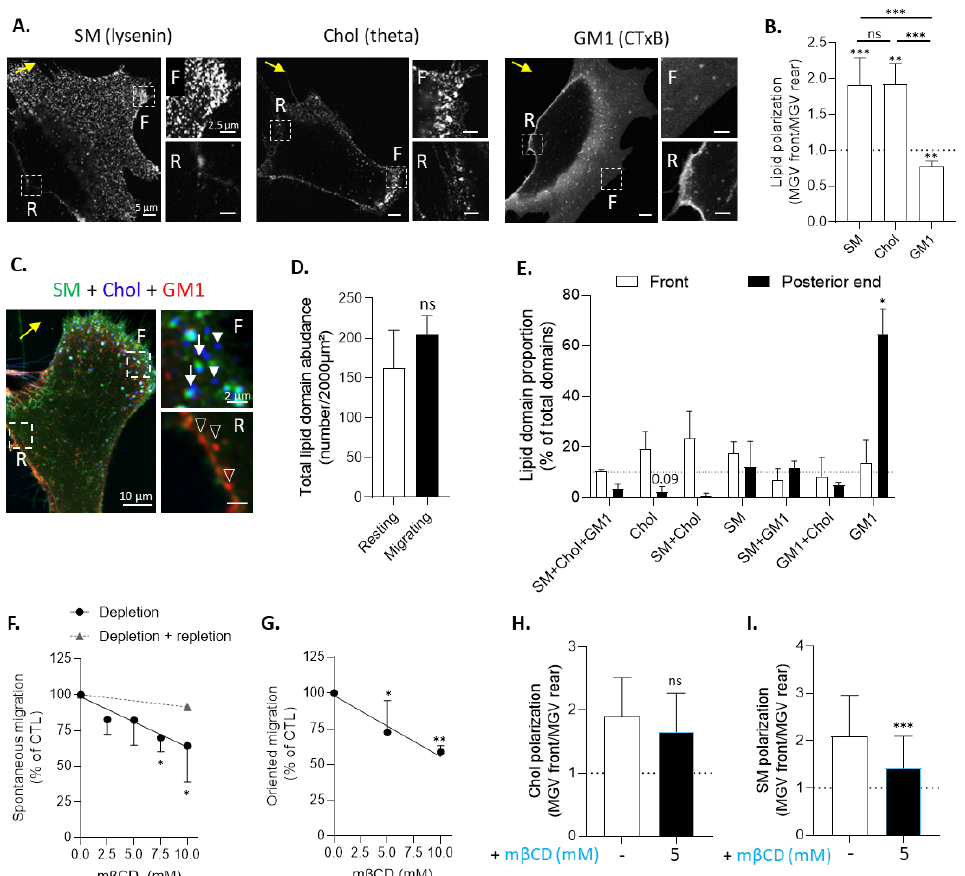
Figure 4. Myoblast migration implies the polarization of chol- and SM/chol-enriched domains at the leading edge vs. GM1-enriched domains at the trailing edge and is impaired by cholesterol depletion. ( A ) Spontaneous migrating cells in Ibidi chambers are single-labeled for SM (lysenin), chol (theta), or GM1 (CTxB) and visualized by super-resolution Airyscan confocal microscopy. Yellow arrow indicates the direction of migration; F is the front; and R is the rear. ( B ) The quantification of lipid polarization. The data are expressed as the ratio of the MGV at the front vs. the MGV at the rear ( n = 10–11 independent experiments). Dotted line is the control value for no polarization. Kruskal– Wallis test, followed by Dunn’s multiple comparisons test. ( C ) Migrating cells were triple-labeled for SM (BODIPY-SM), chol (theta), and GM1 (CTxB) and visualized by super-resolution Airyscan confocal microscopy. Yellow arrow indicates the direction of migration; empty arrowheads are the GM1-enriched domains; white arrows are the SM/chol-enriched domains; and white arrowheads are the chol-enriched domains. ( D , E ) The quantification of lipid domain abundance relative to the cell surface ( D ) and lipid domain proportion at the front and rear of migrating cells ( E ). Dotted line is the threshold for lipid domain acknowledgement. The data are expressed as means ± SD ( n = 3 cells from 1 experiment, 10–15 profiles/zone).Wilcoxon signed-ranked test and two-way ANOVA followed by Sidak’s multiple comparisons test. ( F , G ) The quantification of myoblast spontaneous ( F ) or oriented ( G ) migration in Ibidi chambers or transwells towards IGF-1 after m β CD treatment followed or not by chol repletion (triangle and dotted line). The data are expressed as mean ± SD ( n = 4–11). Kruskal–Wallis test, followed by Dunn’s multiple comparisons test. ( H , I ) The quantification on single-labeled cells of chol (theta, H ) and SM (lysenin, I ) polarization after 5 h of migration in control conditions or after pretreatment with m β CD. The data are expressed as the ratio of the MGV at the front vs. the MGV at the rear ( n = 45–53 cells for each condition from 6 independent experiments). Dotted line indicates no polarization. Unpaired t -test. The statistics above the columns refer to the corresponding control while statistics between different groups are indicated with bars on top of the